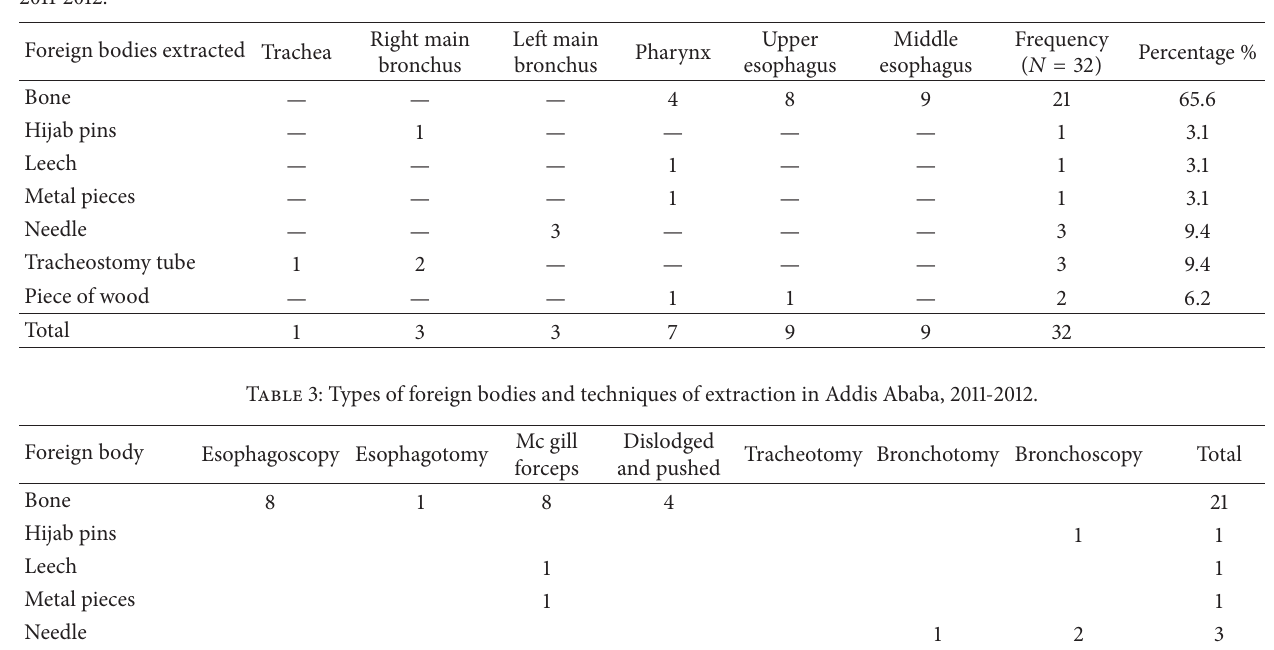
Table 2: Patters and location of foreign bodies extracted from patients who underwent endoscopic foreign body extraction in Addis Ababa, 2011-2012. Foreign bodies extracted Trachea